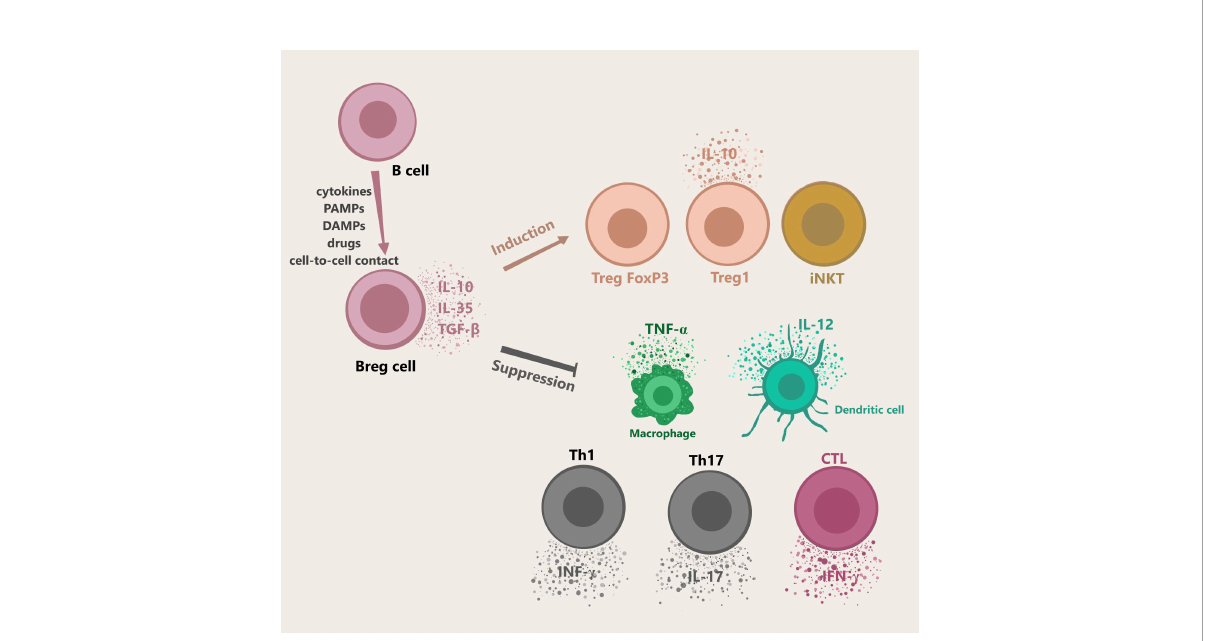
FIGURE 1 Bregs generation, cytokines secretion, and functions. B cells differentiate into Bregs by multiple mechanisms including cell-cell contact, cytokines, or other stimuli e.g. LPS. pDC drives the production of IL-10 secreting Bregs via IFN- a or CD40. Bregs release immunosuppressive cytokines like IL-10, IL-35, TGF- b . Granzyme B-expressing Bregs play a role in suppressing T cell responses. Activated Bregs induce naïve T cells to differentiate into Treg FoxP3 and Treg1, and take part in the maintenance of iNKT function. Moreover, Bregs participate the in suppression of Th1, Th17, CTLs, macrophages, and dendritic cells. Abbreviations: Bregs, regulatory B cells; LPS, lipopolysaccharide; pDC, plasmacytoid dendritic cells; iNKT, invariant natural killer; Th1, T helper 1; Th17, T helper 17; CTLs , cytotoxic T